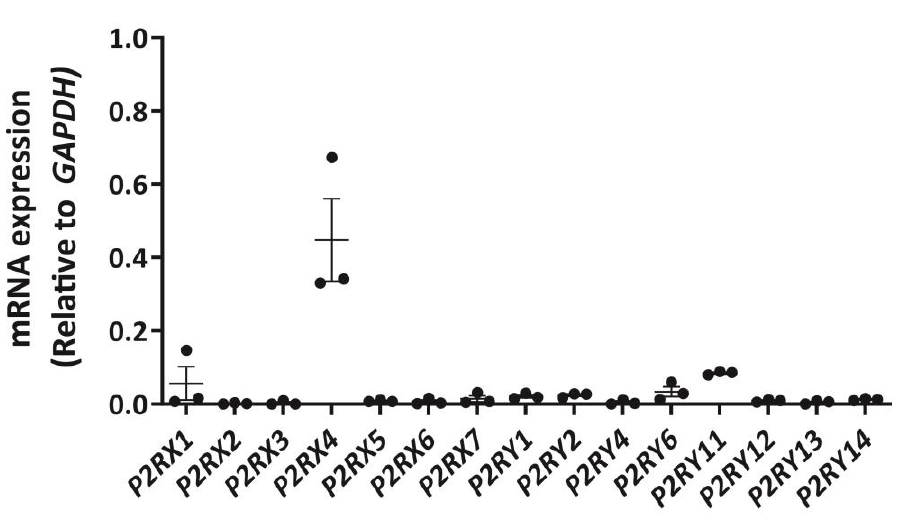
Figure 1. Expression of P2X and P2Y receptor mRNA in DH82 cells. RNA was isolated from DH82 cells and cDNA was synthesized and amplified using primer pairs designed to each respective P2RX or P2RY genes, with glyceraldehyde 3-phosphate dehydrogenase ( GAPDH ) as a positive control. Amplification in absence of cDNA was conducted for each primer pair to ensure primer specificity. Amplicons were visualized by agarose gel electrophoresis using GelRed and the GelDoc XR + imaging system and semi-quantitatively analysed by densitometry. Data shown are the mean ± SEM relative to GAPDH expression from three independent experiments.